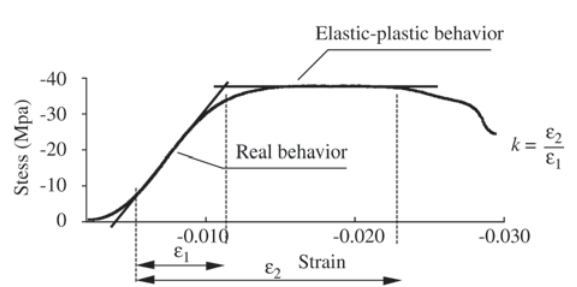
Figure 7. Stress vs. strain in compression parallel to grain.